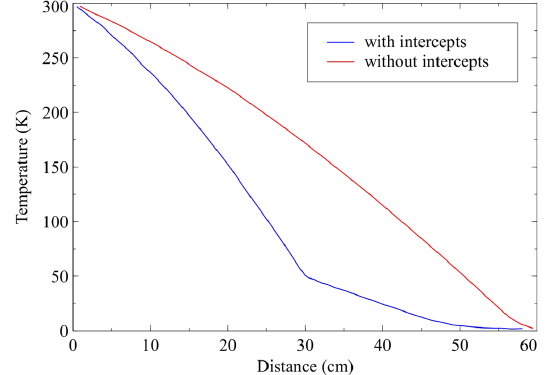
FIG. 5. Temperature as a function of position on the waveguide.